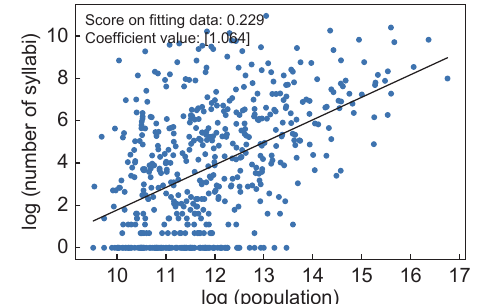
Fig. 5 log-log plot of the number of research abstracts versus the population size for MSAs.